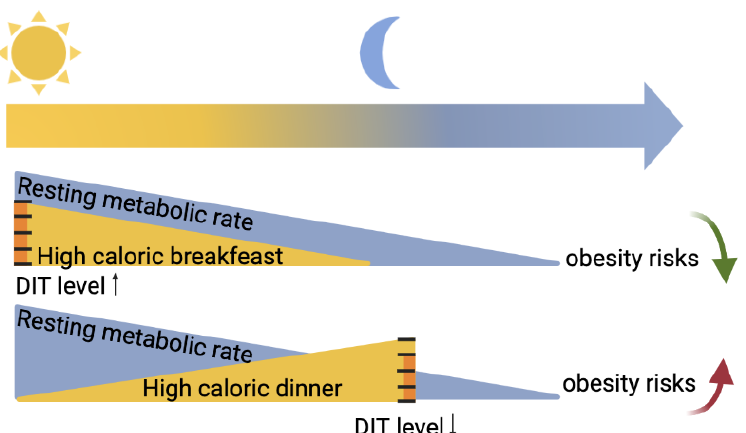
Figure 2. Changes in resting metabolic rate and diet-induced thermogenesis (DIT) over the course of a day. The resting metabolic rate in humans follows a daily rhythm, with higher values during the day than during the night. It is advisable to favor caloric meals when the resting metabolic rate is high, i.e., in the morning, and minimize it when it is lower, i.e., before bedtime. For the same caloric intake, the DIT level is higher in the morning than in the evening. Depending on the characteristics of the DIT, eating in the morning (high DIT) would be more advantageous for weight loss and preventing obesity than eating rich meals in the evening (lower DIT). Created with https://www.biorender.com/ (accessed on 10 February 2023).